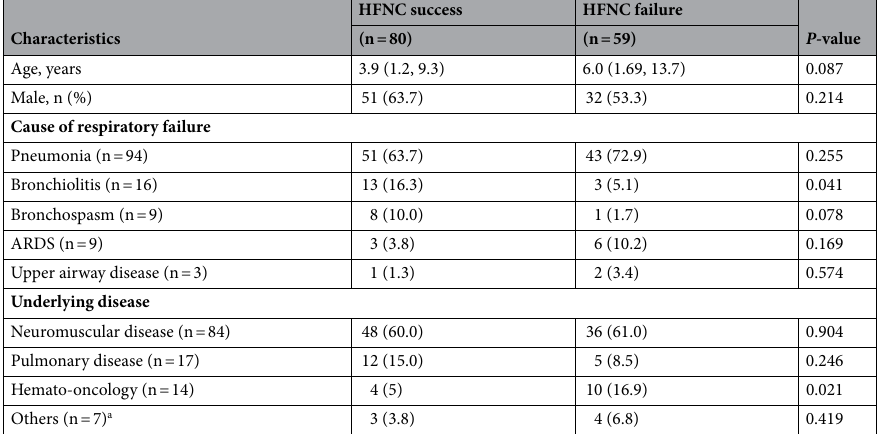
Table 1. Patient characteristics in the exploratory group. Data are expressed as n (%) or medians (interquartile ranges). n, numbers; HFNC, high flow nasal cannula; ARDS, acute respiratory distress syndrome; FiO 2 , fraction of inspired oxygen; SpO 2 , pulse oximetry oxygen saturation; P/F, PaO 2 /FiO 2 . a Others include systemic lupus erythematosus (three patients), metabolic disorder (two patients), and chronic kidney disorder (two